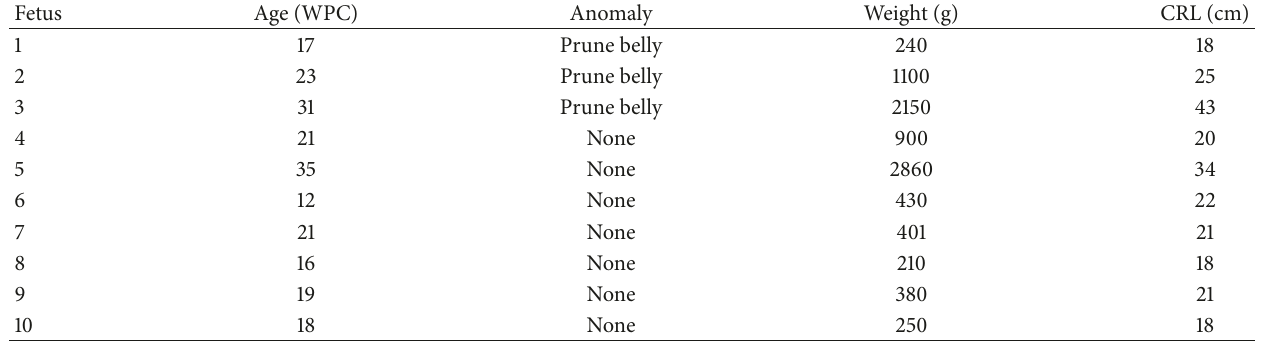
Table 1: The table shows the age and the fetal parameters of our sample: 7 male fetuses without anomalies and 3 male fetuses with prune belly syndrome. The 10 fetuses had abdominal testis. WPC = age in weeks postconception; g = grams; CRL = crown-rump length, and cm = centimeters.